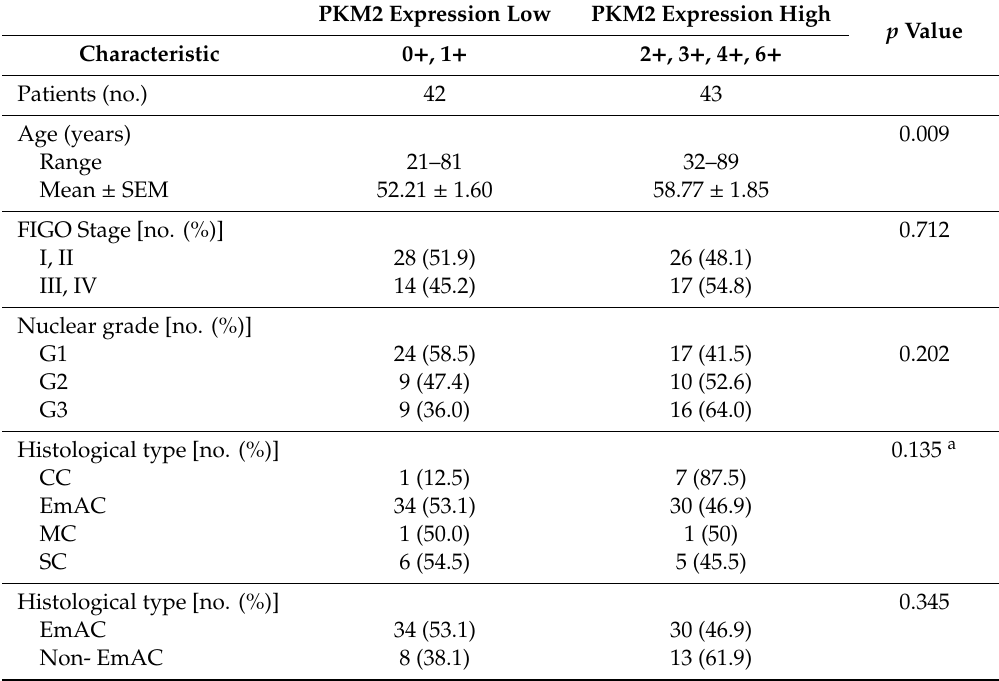
Table 2. Clinicopathological features in 85